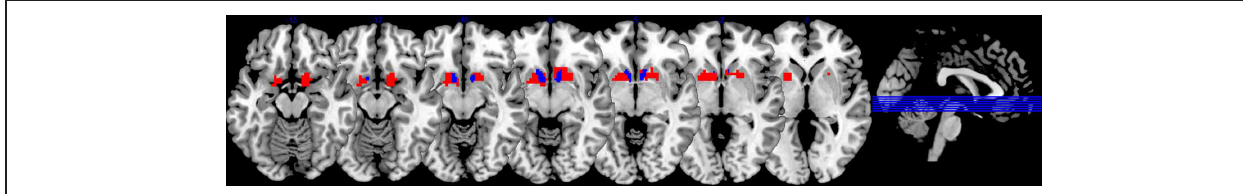
FIGURE 2 | ROI Masks. In red: Voxels within the striatum which show a reward-related signal (derived from the contrast C2, C3 > C1, C4, and C5) on a P FWE < 0 . 05 (per voxel), whole brain corrected. In blue: anatomically defined NAcc mask (according to Harvard-Oxford brain